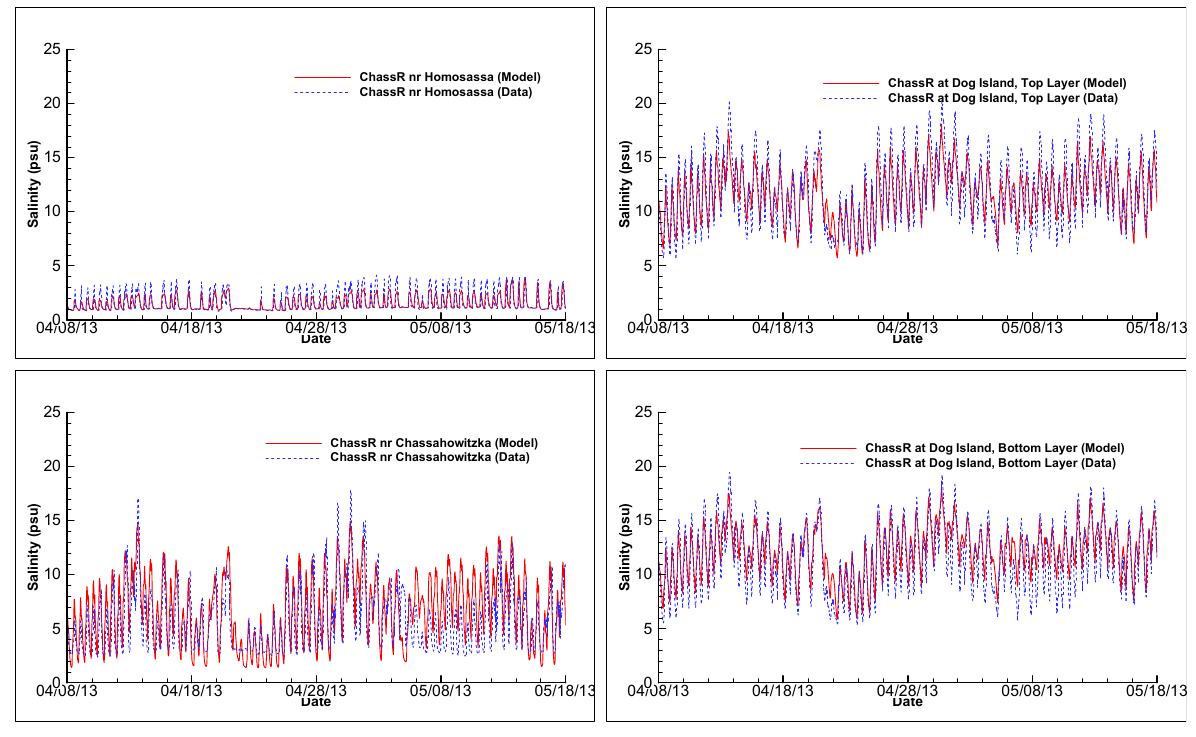
Figure 8. Comparison of measured and simulated salinities at the CRH ( top left panel), CRC ( bottom left panel), and CRD ( top right panel for top layer, bottom right panel for bottom layer) stations from 8 April 2013 through 18 May 2013.